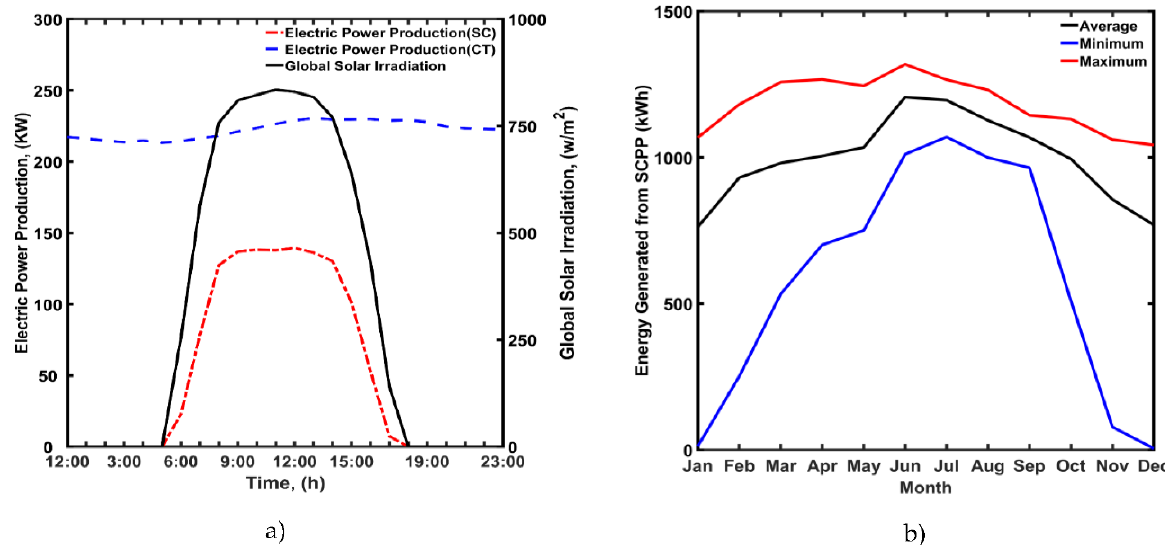
Figure 5. Daily performance of the SDCPP: ( a ) electricity production profile from SCPP and CT modes, ( b ) daily cumulative average energy produced by the SCPP mode. The data presented were taken on 30